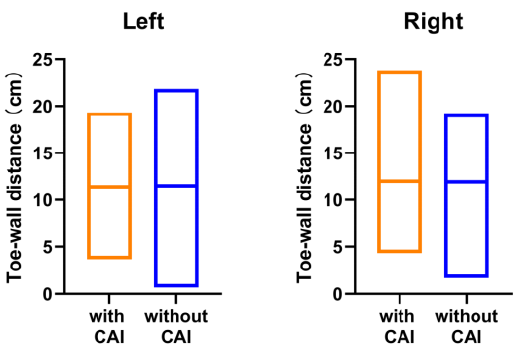
Figure 2. Navicular drop between the groups with and without CAI (measured using navicular drop test). There is no significant difference between the groups (left: p = 0.12; right: p = 0.68).